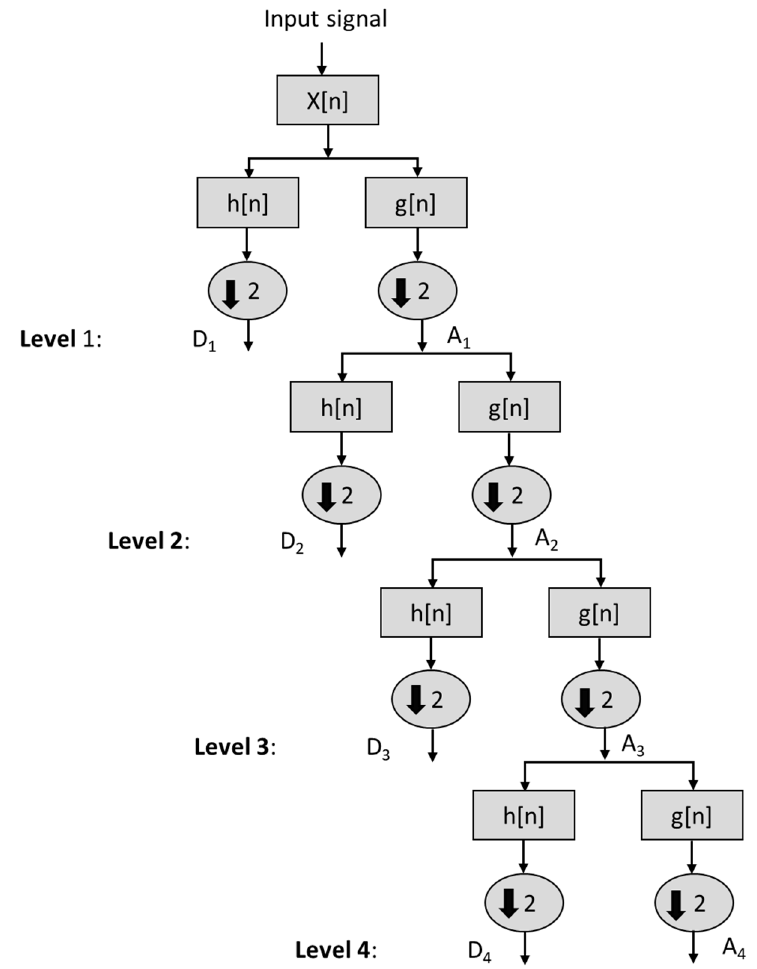
Figure 4. Decomposition of input signal x[n] using DWT with ‘db10’ and up to level 4.